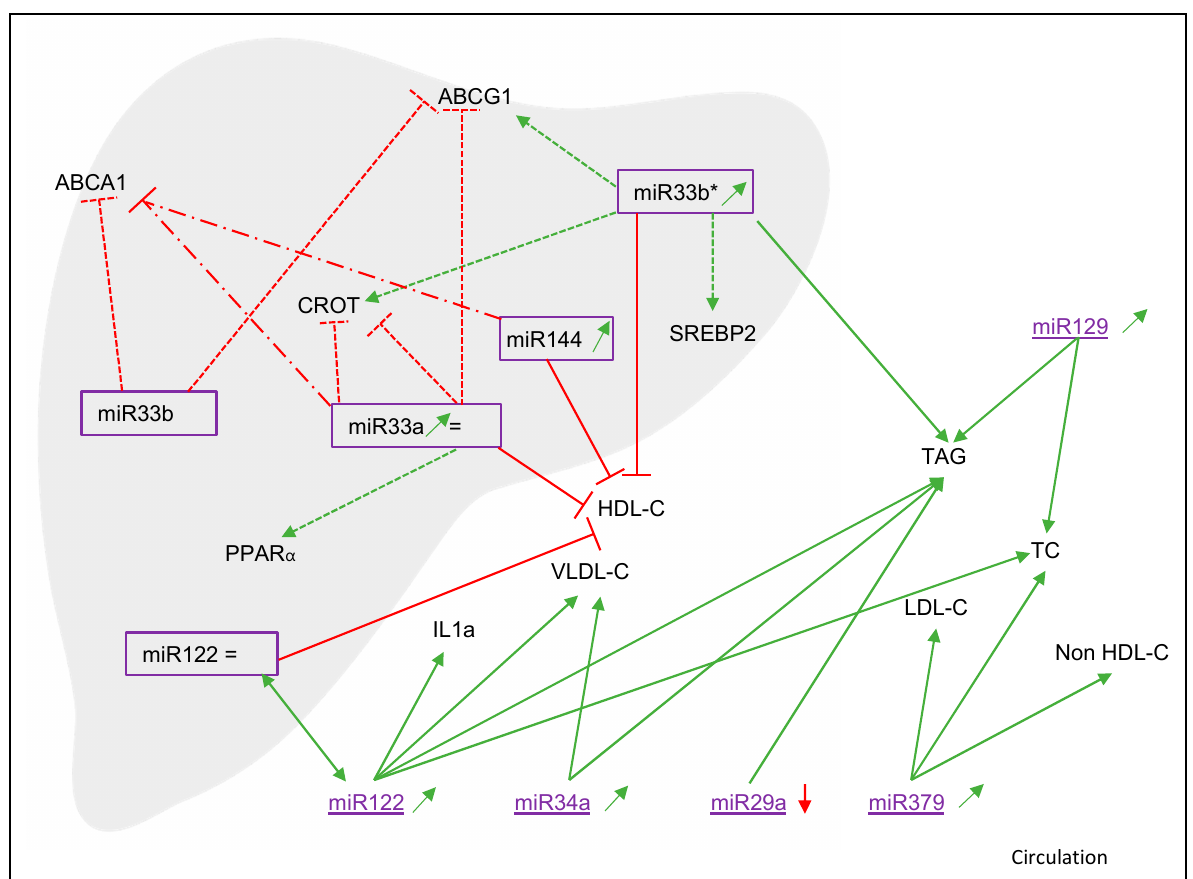
Figure 3. Relations between miRNAs, genes and cholesterol metabolism. Green: positive correlations; red: inverse correlations; small dotted lines: mRNA levels; broad–small dotted lines: protein levels; solid lines: other relations. Red arrow is downregulated. Green arrow is upregulated, = is no change; IL-1 α —Interleukin 1 alfa; TAG—triacylglycerol; VLDL-C—very-low-density